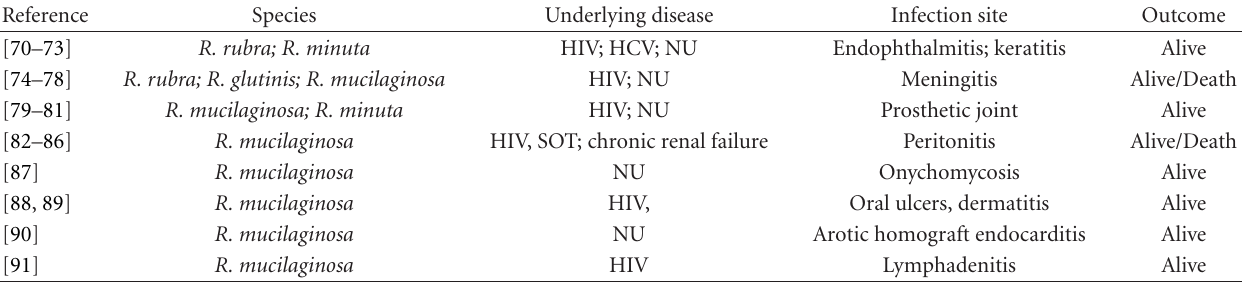
Table 2: Summary of reports of Rhodotorula infections other than fungemia from 2000 to